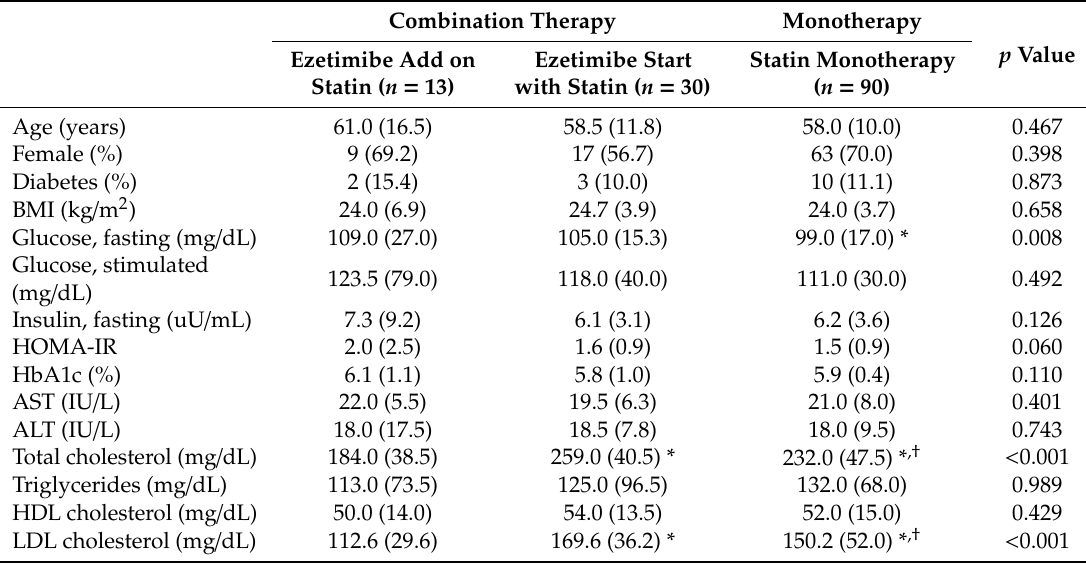
Table 1. Baseline characteristics of the study